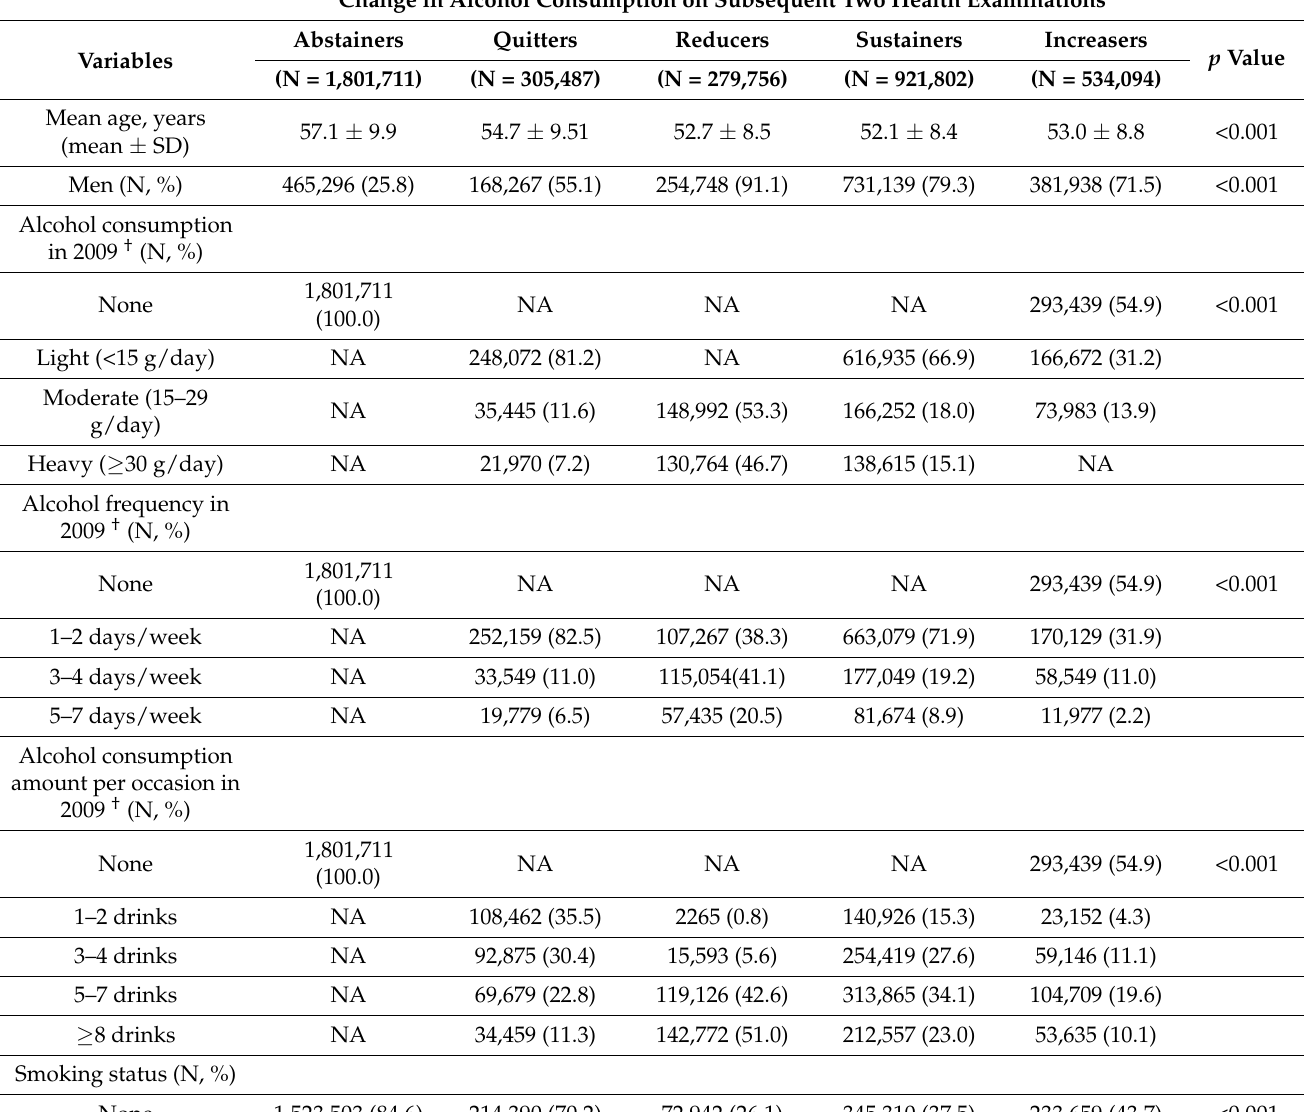
Table 1. Baseline characteristics of the study